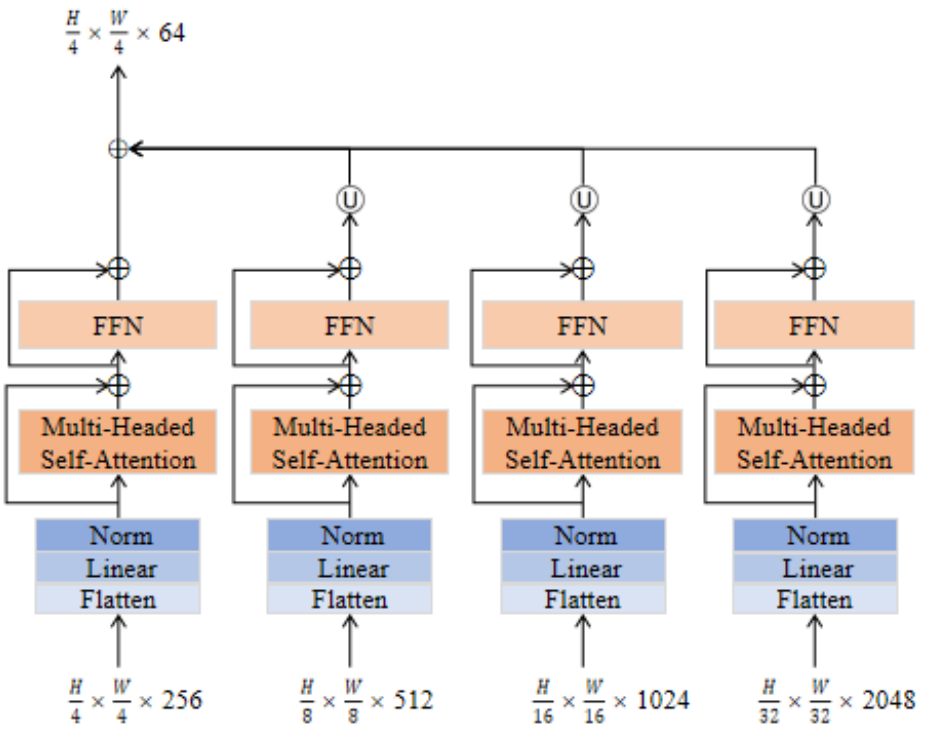
Figure 2. Contextual attention module structure .